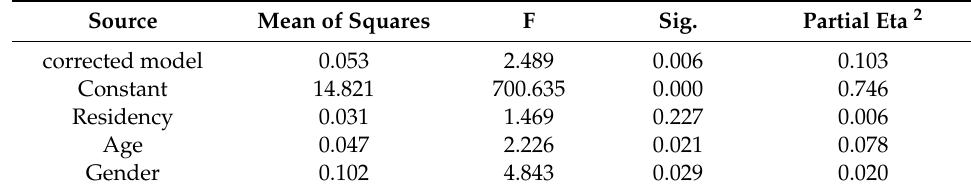
Table 3. Univariate model with knowledge scores as a dependent variable with age, gender, and residency as independent predictors. Partial Eta 2 can be understood as the explained variance.